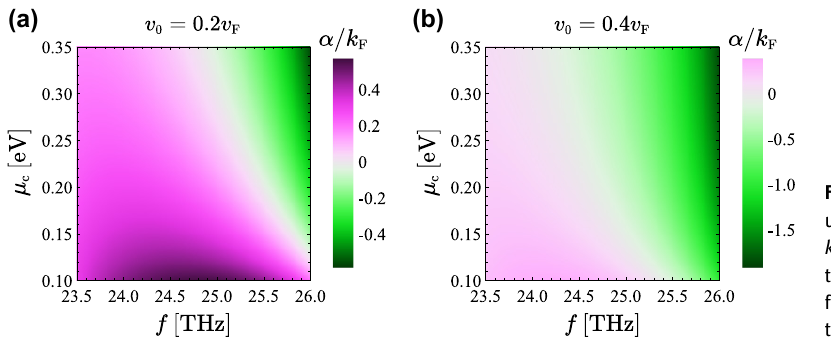
. In all c = 𝜀 r , s r , SiC